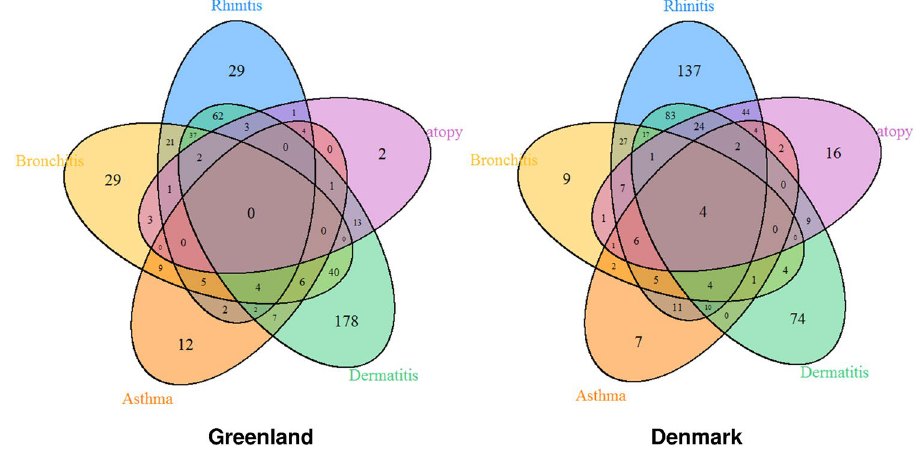
Figure 1. Interrelations of the respiratory/allergic diseases: Venn diagram shows the interrelations of the respiratory/allergic diseases in the two